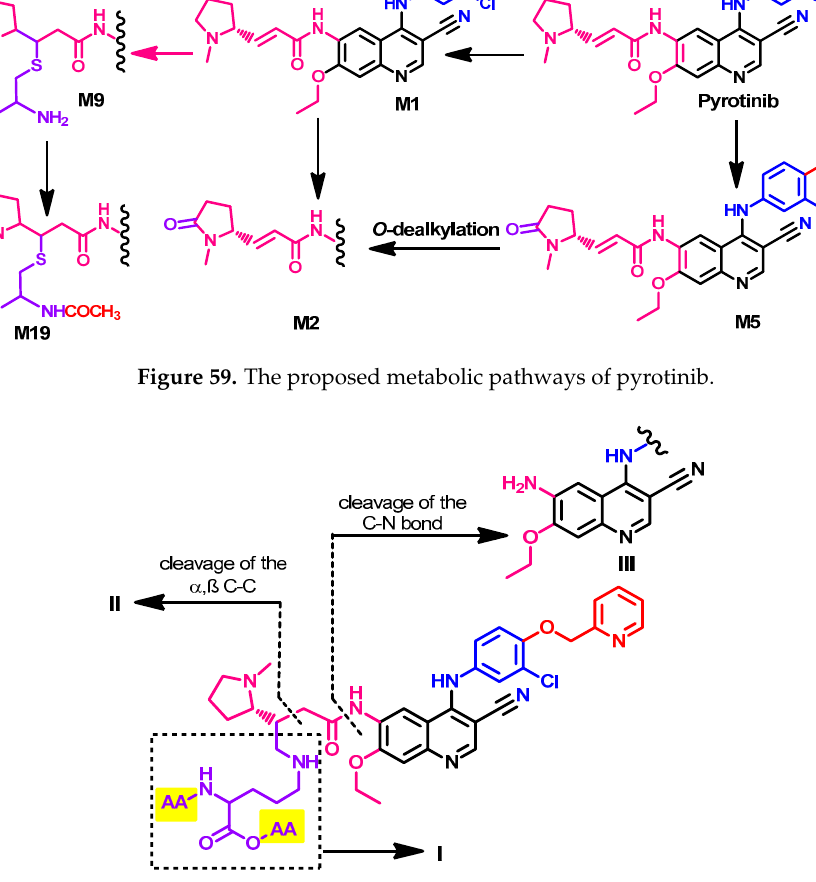
Figure 60. General structure of [ 14 C] pyrotinib plasma protein adducts showing the proposed fragmentation pathway and sites of cleavage; AA, amino acid.